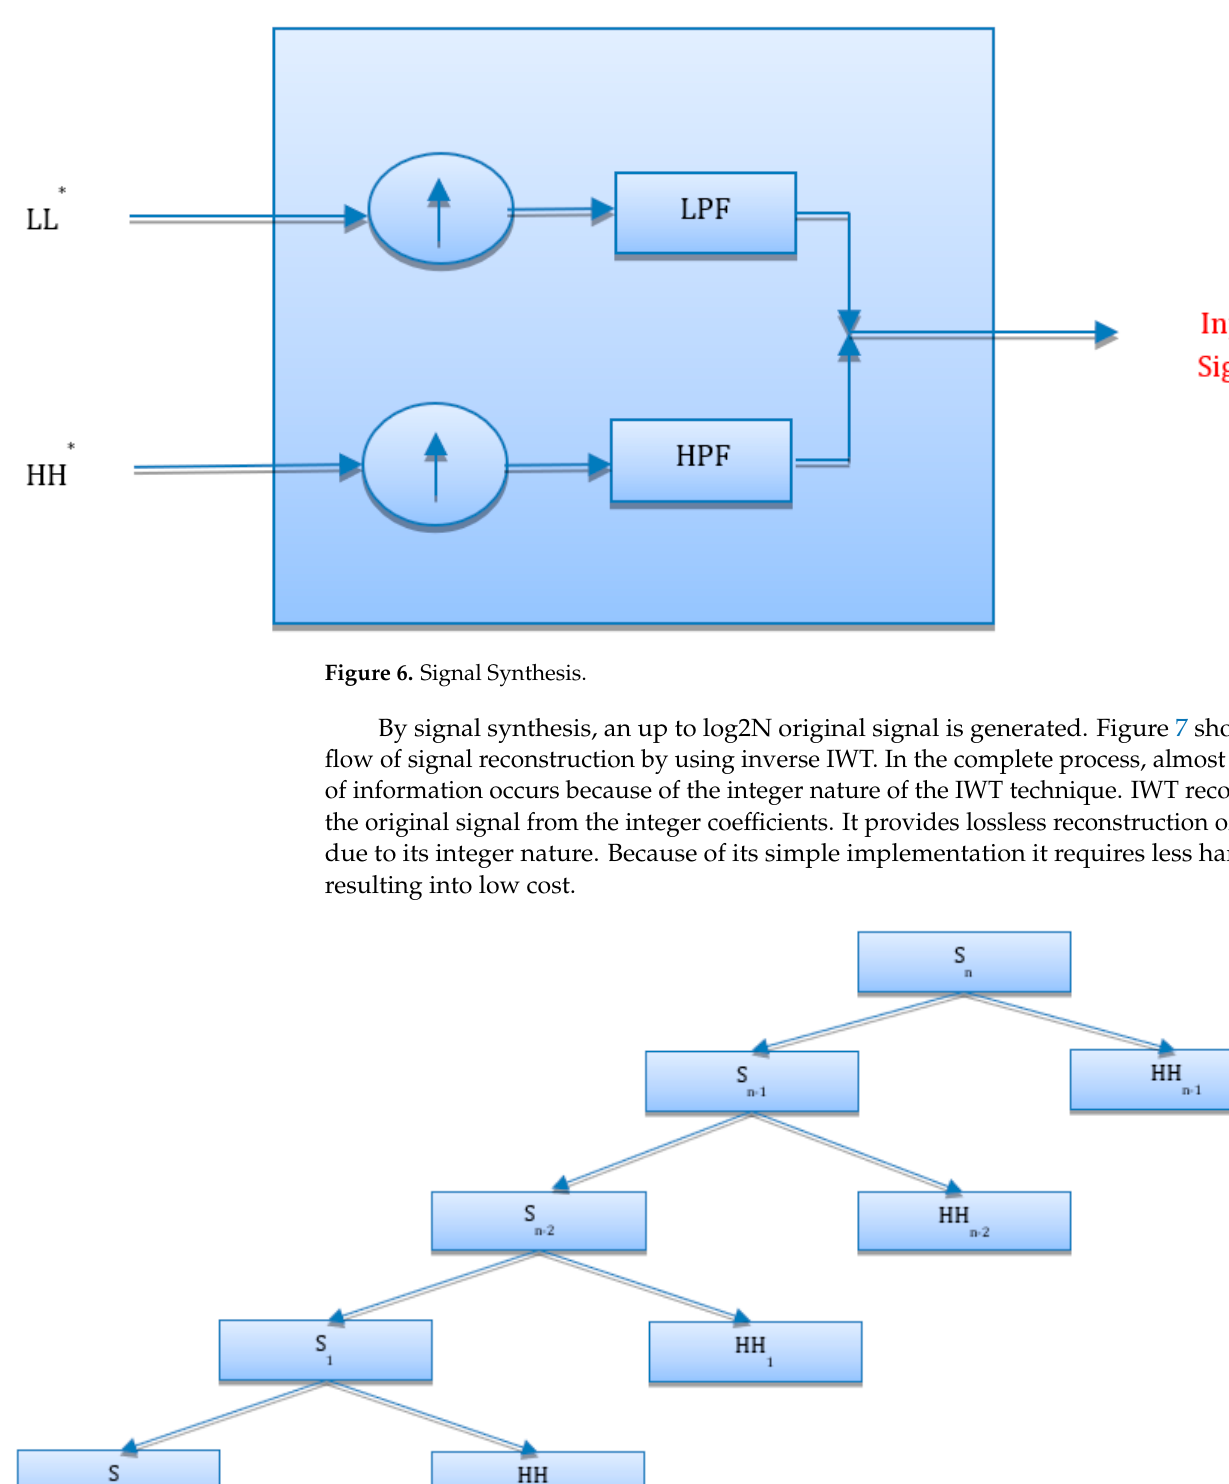
8 of 17 Figure 5. Wavelet Decomposition. After a complete analysis of the input signal by using inverse IWT signals, synthesis